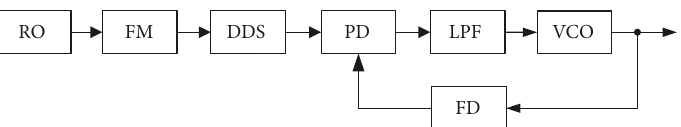
Figure 3: The block diagram of the hybrid frequency synthesizer with DDS as a reference PLL oscillator.